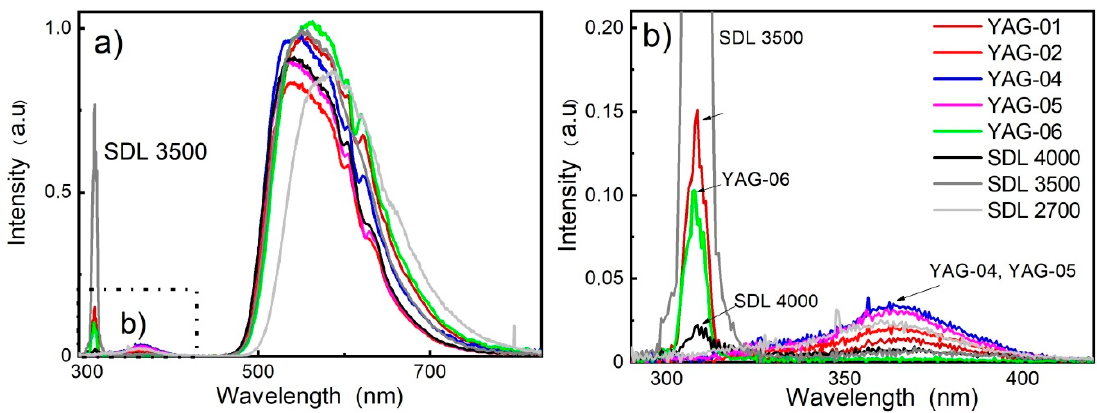
Figure 7. Cathodoluminescence (CL) spectra of SDL and C-YAG phosphors ( a ); enlarged luminescence spectra in the UV region ( b ).